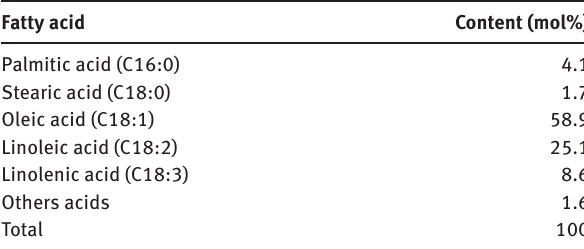
Table 1: Fatty acids profile of the rapeseed oil used in this work (determined by HPLC from the products of rapeseed oil hydrolysis in supercritical water at 270 ° C, 20 min and oil/water =